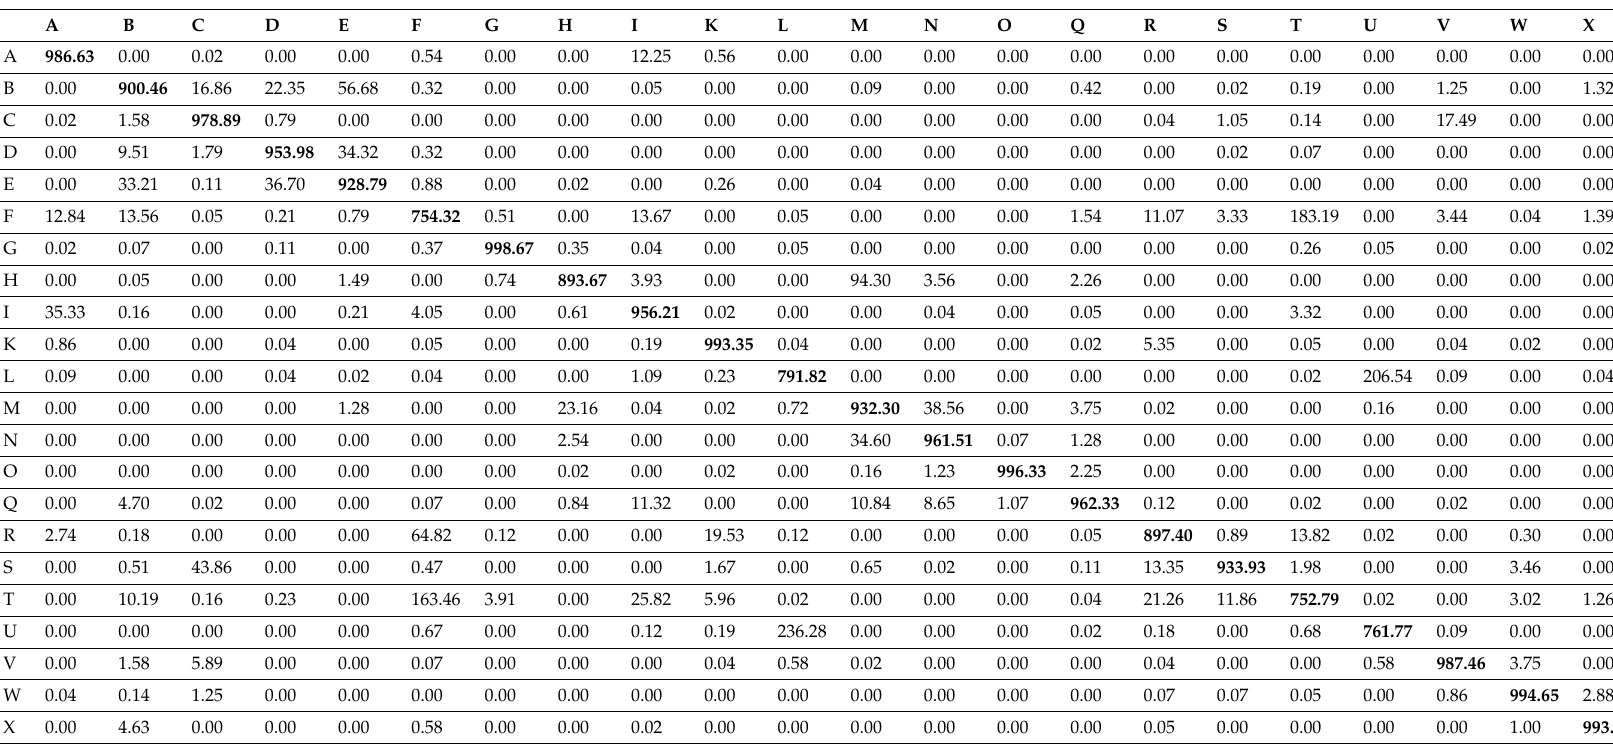
Table 2. The confusion matrix for the random forest classifier’s 24 recognized fingerspelling signs. Visible are minor confusions between ’L’ and ’U’, and ’T’ and ’F’. Overall accuracy is 92.4% (with a standard deviation of 0.042), the overall F1-score is 91.3% (with a standard deviation of